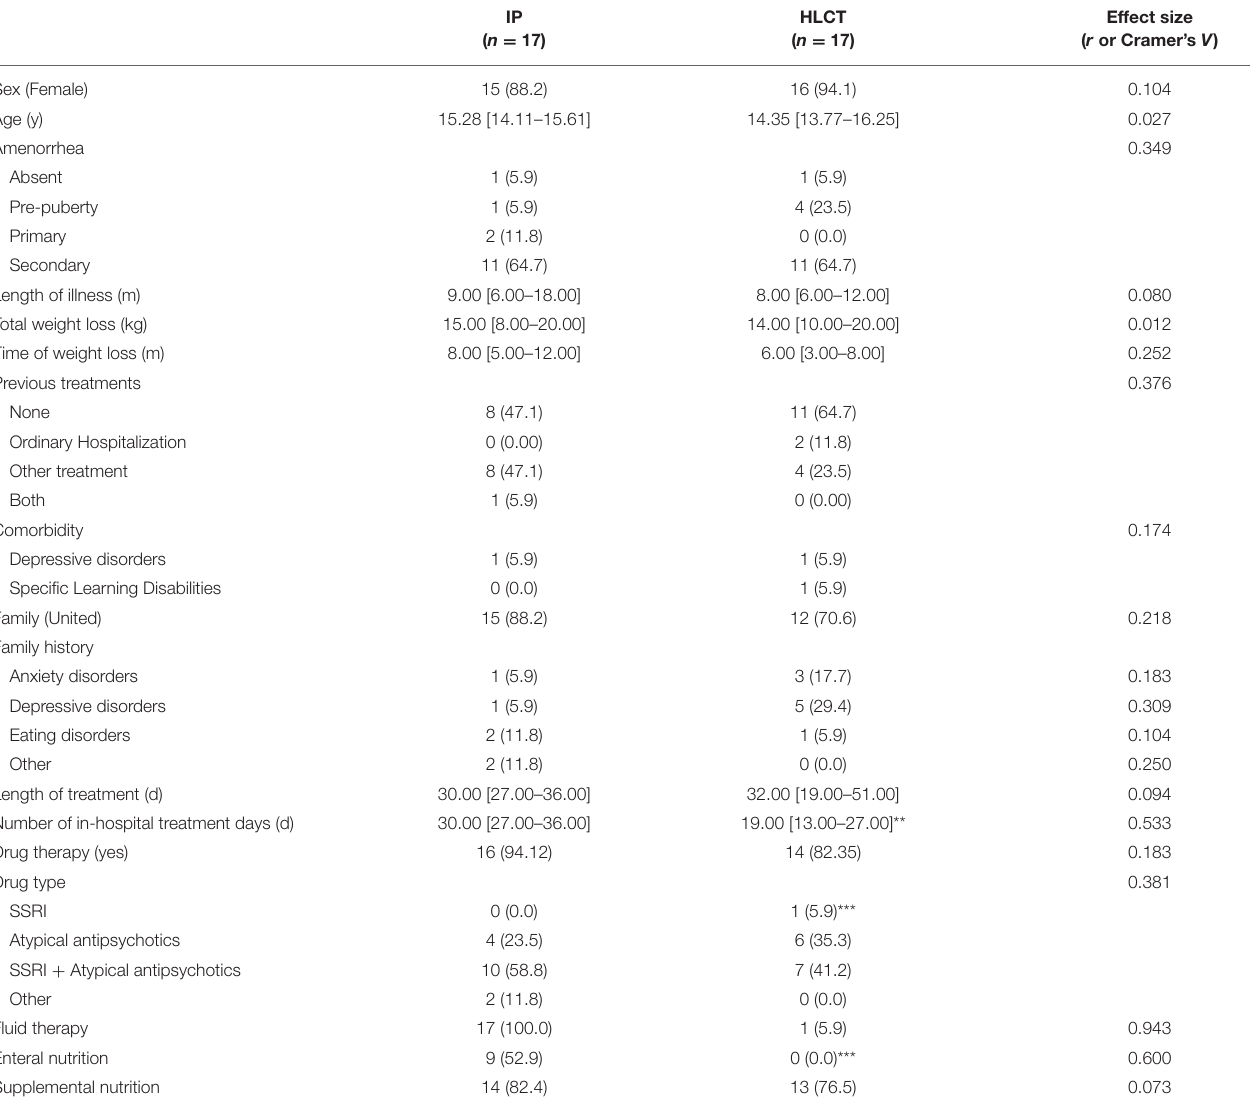
TABLE 1 | Patients’ characteristics in IP and HLCT